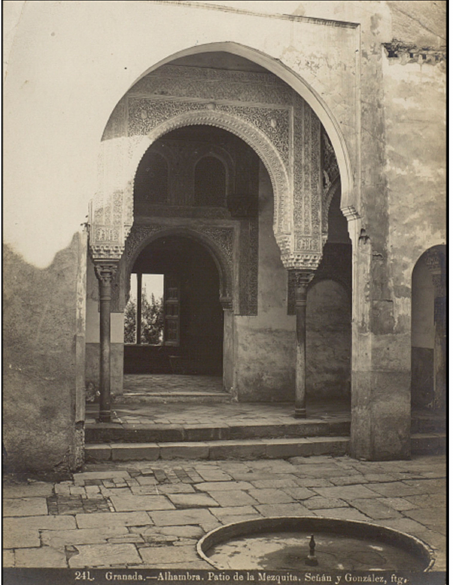
Figure 22. Portico and Cuarto Dorado before dismantling the 16th century arches. The photograph shows the alicatado work below the mullioned window, looking toward the east. Photograph by Rafael Señ á n y Gonz á lez (undated). © Archivo del Patronato de la Alhambra y Generalife, Photograph Collection,